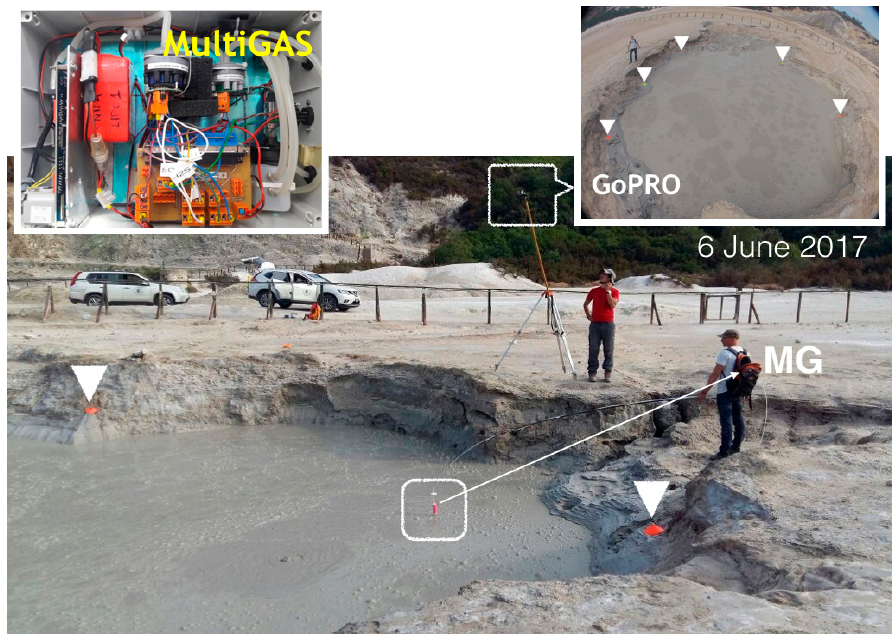
Figure 2. Image showing the field procedure to measure CO 2 and H 2 S concentrations above the surface of Fangaia using a fishing rod, long tubing, and a MultiGAS device (MG, left inset). The distances between fluorescent cones are measured in the field (right inset) and the entire field of view is obtained by using fish-eye lens on a GoPRO camera elevated on a tripod. Minerals 2020 , 10 , x